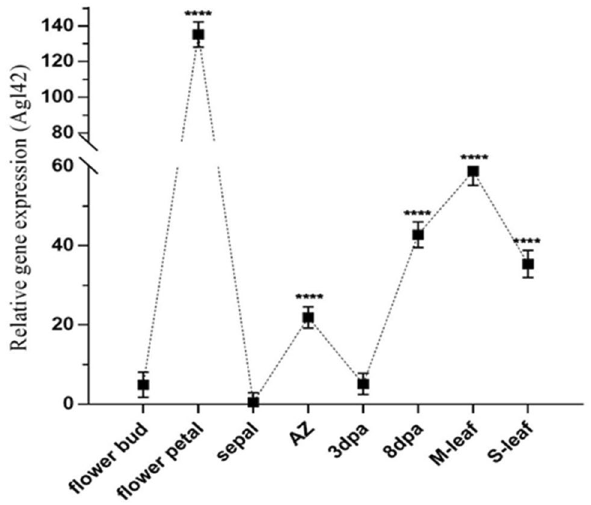
Figure 3. mRNA expression analysis of AGL42 gene in different tissues through qRT-PCR. Each value depicts the average of technical and biological triplicates in AG3 transgenic line. Asterisks specify significant variation “****Pvalue ≤ 0.0001”.